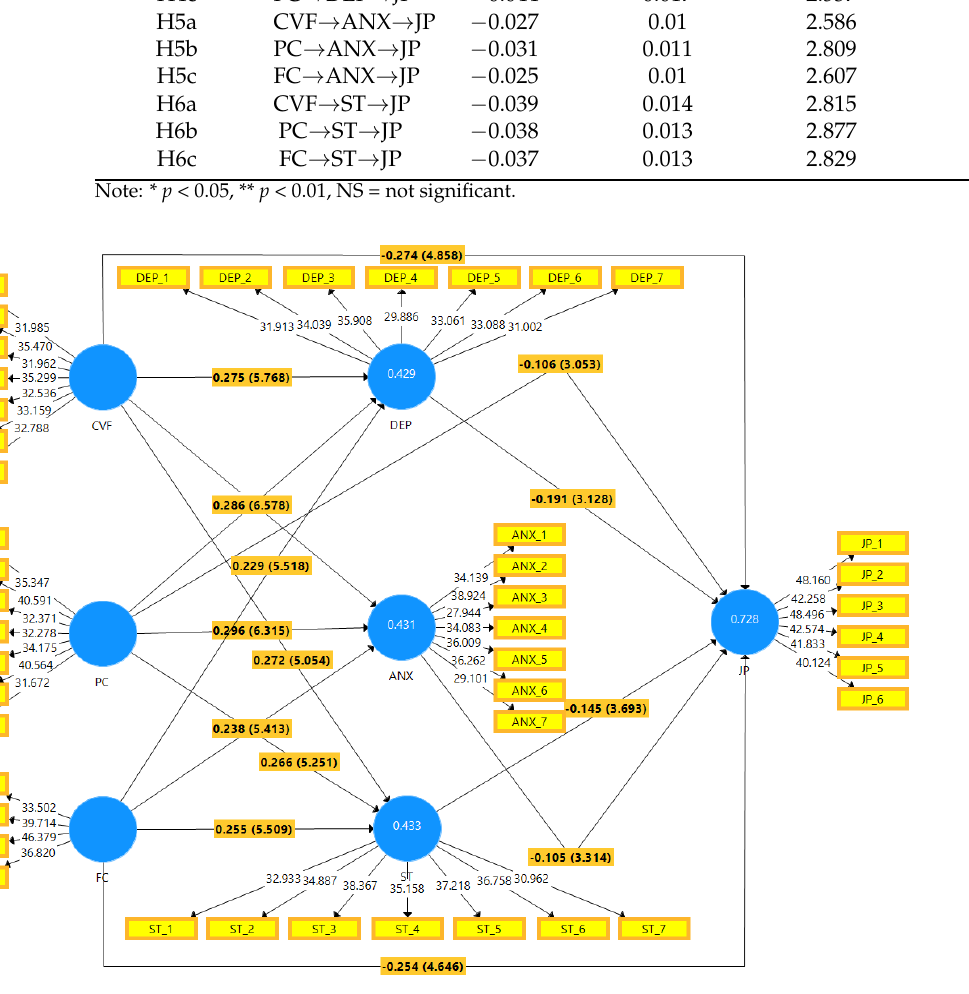
Figure 3. Graphical representation of the structural model.